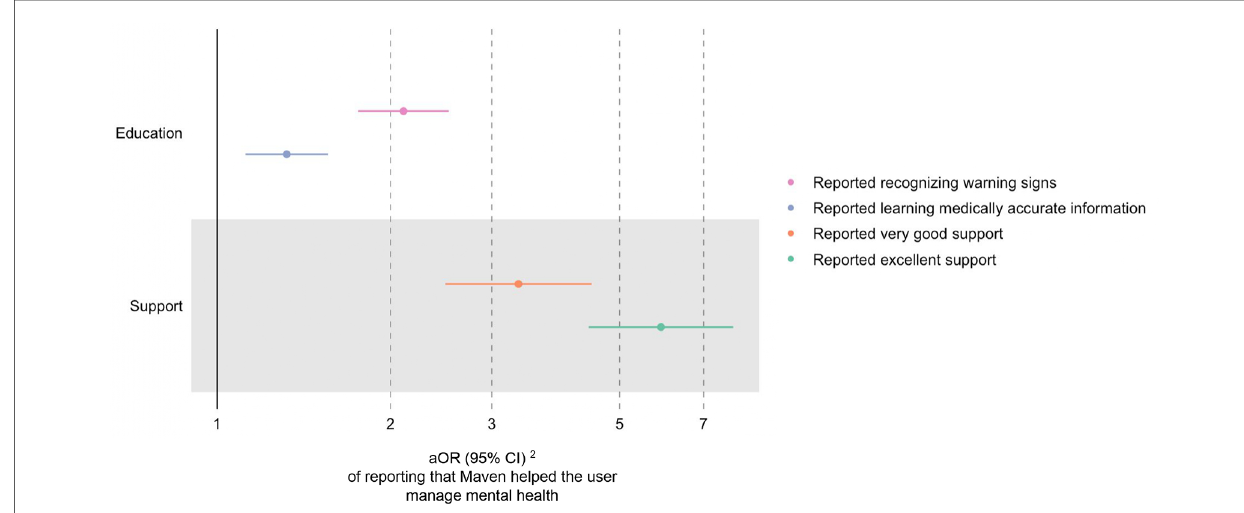
FIGURE 5 Effect of education and support on mental health management in total sample 1 . 1 Filled data points represent statistically signi fi cant fi ndings ( p <0.05), and un fi lled data points represent fi ndings that are not statistically signi fi cant. 2 Adjusted odds ratio (95% con fi dence